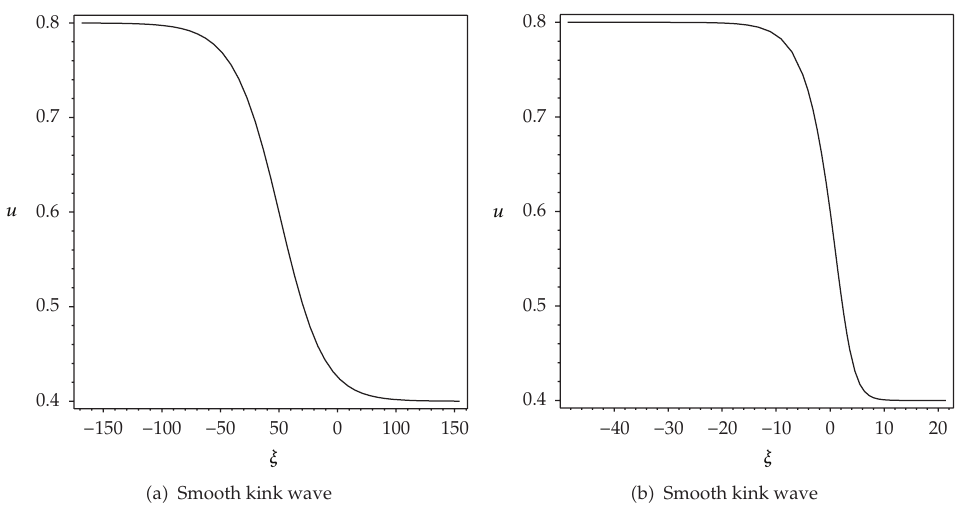
Figure 4: The profiles of kink wave solution (cid:2) the first solution of (cid:2) 3.12 (cid:3)(cid:3) for the given parameters and di ff erent (cid:2) ε,κ (cid:3) -values: (cid:2) a (cid:3) ε (cid:7) 0 . 2 , κ (cid:7) 7 . 2 , t (cid:7) 0 , n ∈ (cid:4) − 30 , 30 (cid:5) ; (cid:2) b (cid:3) ε (cid:7) 1 . 22 , κ (cid:7) 0 . 5333333334 , t (cid:7) 0 . 2 , n ∈ (cid:4) − 110 , − 50 (cid:5)